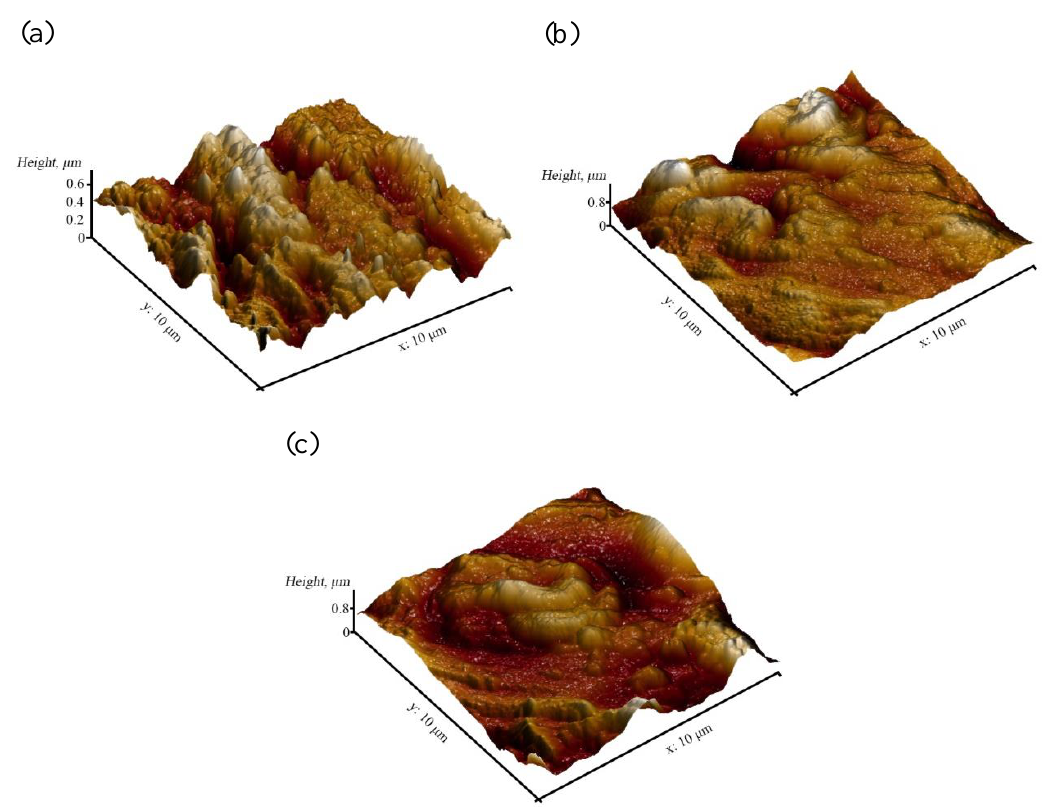
Figure5. AFMimagesoftheTacoatingsonthealuminumtemperaturegradientsubstrate. Condensation Figure 5. AFM images of the Ta coatings on the aluminum temperature gradient substrate. temperature: ( a ) 300–350 ◦ C, ( b ) 390–420 ◦ C, and ( c ) approximately 450 ◦ Condensation temperature: ( a ) 300–350 °С, ( b ) 390–420 °С, and ( c ) approximately 450 °С.